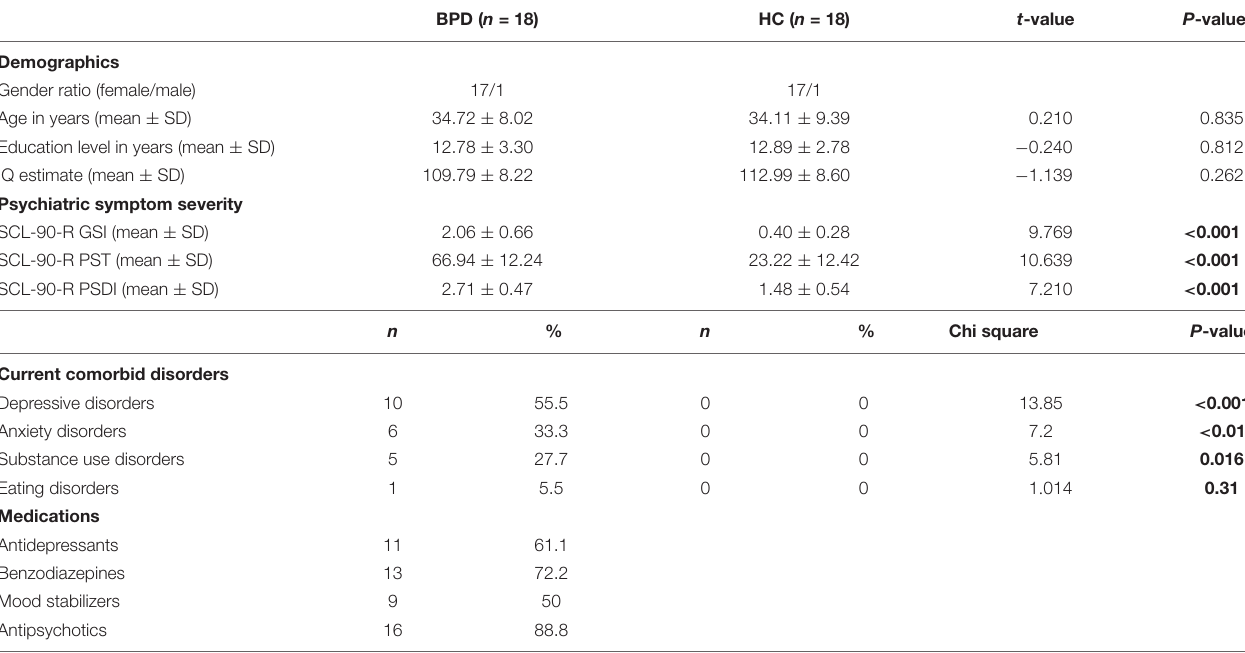
TABLE 1 | Demographic and clinical characteristics of the study